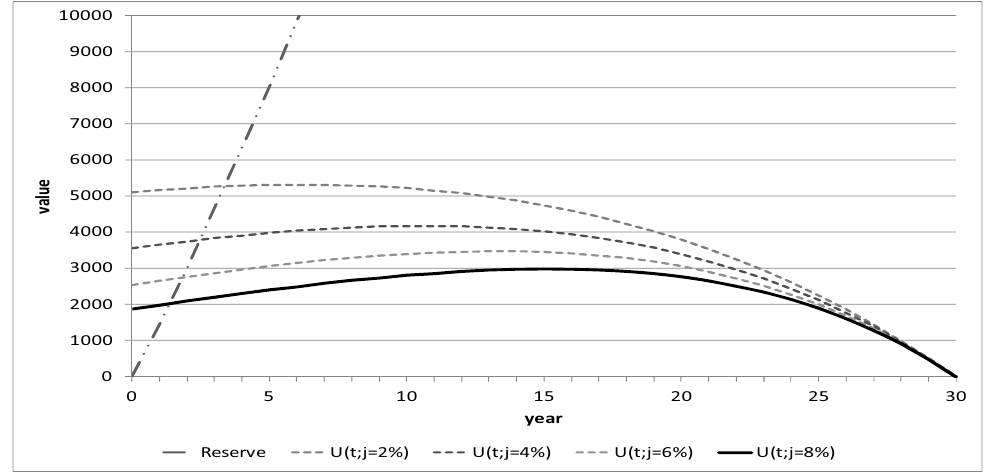
(cid:5) U for different evaluation rate j values t